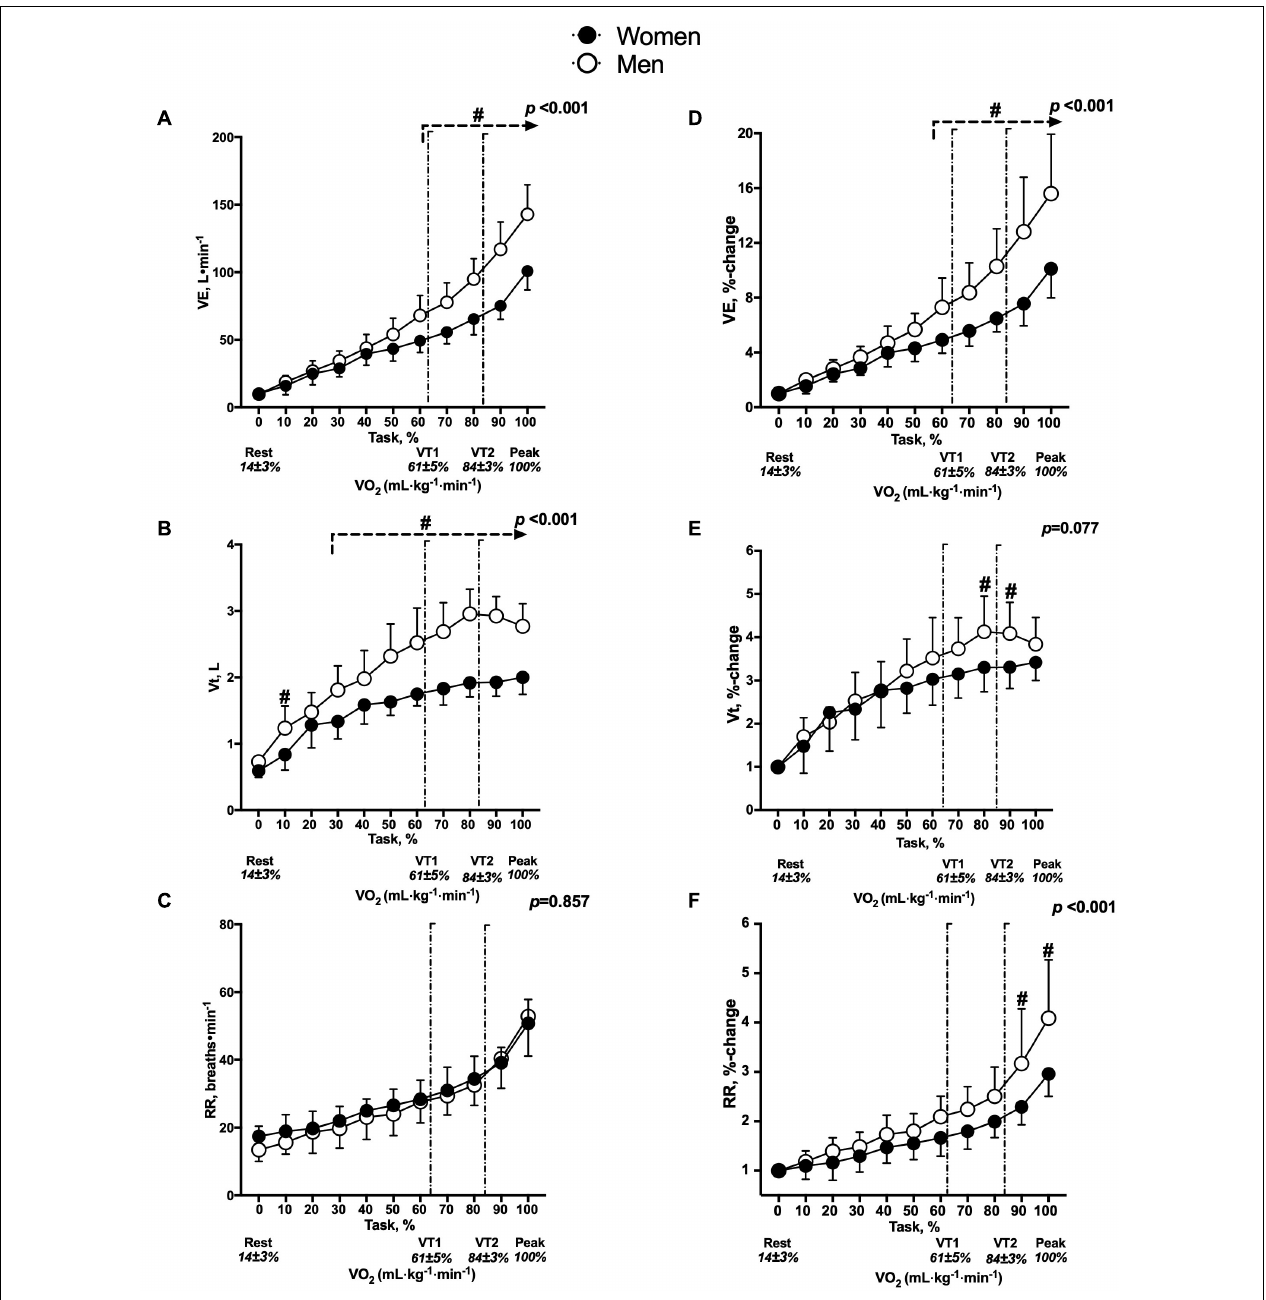
FIGURE 3 | Changes in ventilatory variables between men and women. The panels on the right indicate absolute values, (A) ˙ VE (L · min − 1 ), (B) Vt (L) and (C) RR (breaths · min − 1 ). The panels on the left indicate the percentage to rest, (D) ˙ VE (%-change), (E) Vt (%-change) and (F) RR (%-change). # p < 0.05: comparison between sex with respect to percentage of task. The two vertical lines represent the ventilatory thresholds (VT1, 61 ± 5% to VO 2 - peak and VT2, 84 ± 3% to VO 2 - peak ). The interaction between factors (sex × time) is represented by the p-